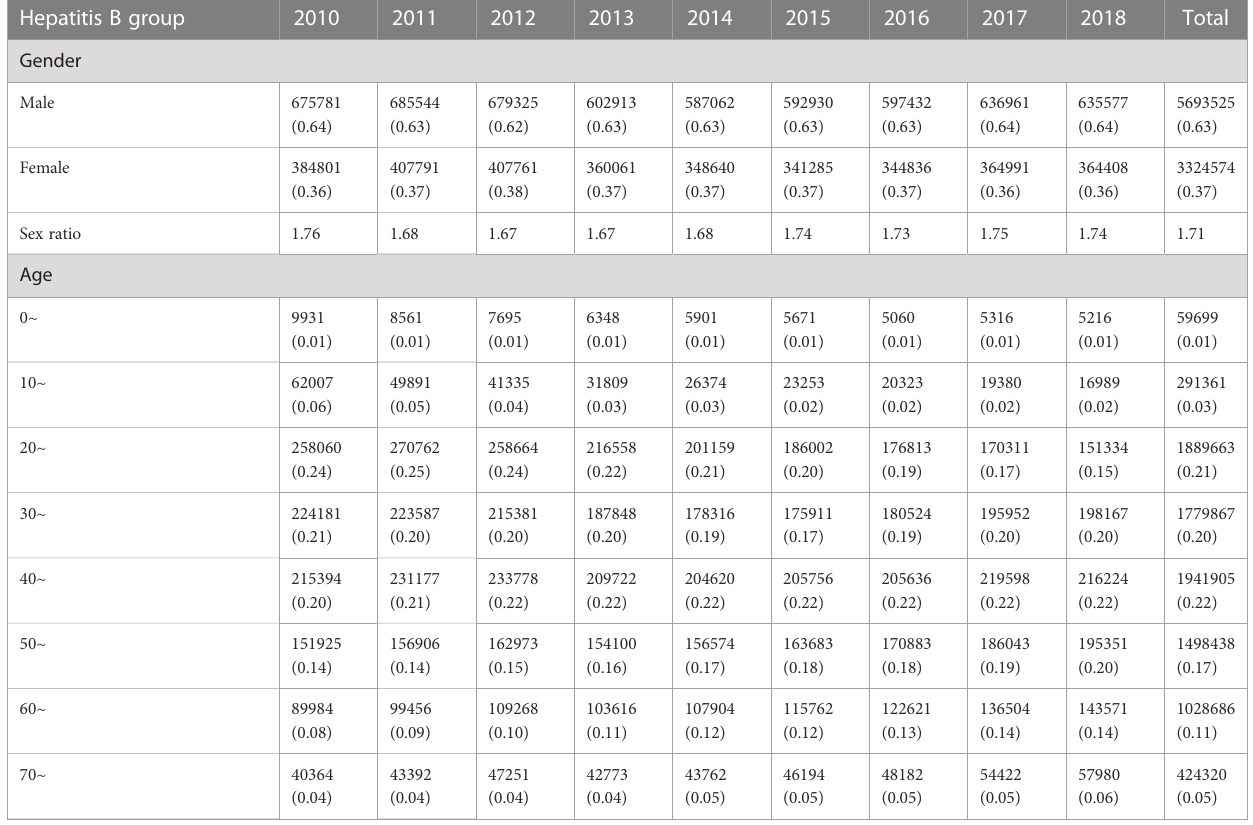
TABLE 1 Demographic characteristics of hepatitis B cases in mainland China, 2010 –